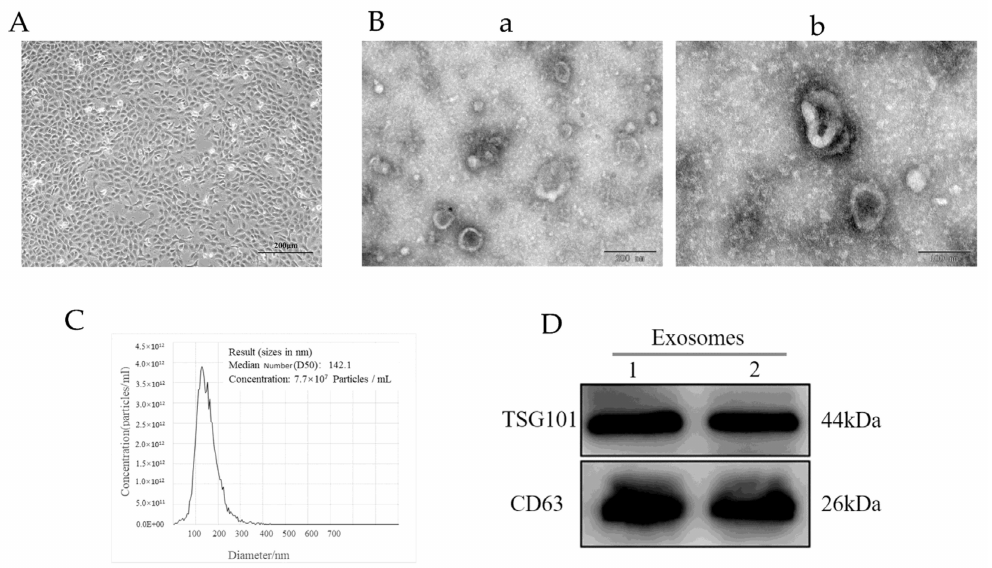
Figure 1. Identification of yak follicular fluid exosomes. ( A ) Phase morphology of isolated YCCs. Scale bar represents 200 µ m. ( B ) Size and shape of yak follicular fluid exosomes (white arrows) determined using transmission electron microscopy (TEM). Scale bar represents ( a ) 200 and ( b ) 100 nm. ( C ) Size distribution and concentration of yak follicular fluid exosomes using nanoparticle tracking analysis (NTA). ( D ) Western blot analysis (See Figure